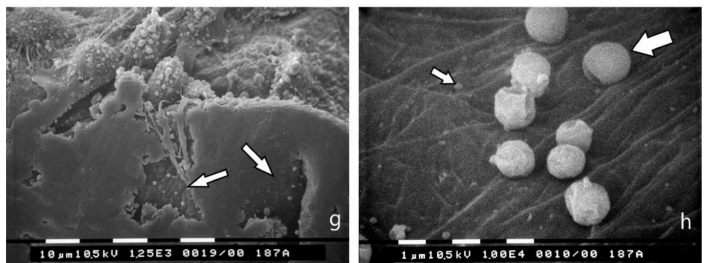
Figure 6. Breast cancer cells cultured on collagen type I fibers bundled parallel to the culture plane (TACS II). ( a ) Section of the collagen membrane of Achilles tendon including collagen fibers parallel to the culture plane used as substrate for culture of breast cancer cells. Bar 100 µ m; ( b ) MCF-7 cells on collagen membrane appear as grouped globular/spherical cells with many microvilli but no microvesicles. Bar 100 µ m; ( c ) Grouped MDA-MB-231 cells on the same collagen membrane show globular/spherical shape and elongated and spindle-like ones. Bar 100 µ m; ( d ) At a higher enlargement, four MCF-7 cells show cell-cell contacts and many microvilli on their cytoplasmic surface. Bar 10 µ m; ( e ) At higher enlargement the globular/spherical MDA-MB-231 cells appear covered by many microvesicles, which are very few on elongated or spindle-like cells. Bar 10 µ m; ( f ) A spindle-like MDA-MB-231 cell with microvilli shows two invadopodia (arrow) degrading the collagen fibrils (easily recognizable in the lower portion of the picture). Bar 1 µ m; ( g ) MDA-MB-231 cells are visible on the collagen membrane but not in the thickness of the same substrate. However, many exosomes and microvesicles (arrows) shed by MDA-MB-231 cells penetrated the superficial thickness of the collagen membrane and are visible in the inter fiber spaces. Bar 100 µ m; ( h ) At higher enlargement, exosomes (small arrow) and microvesicles (large arrow) lying on collagen fibrils are clearly visible in the thickness of the collagen membrane. Bar 1 µ m.